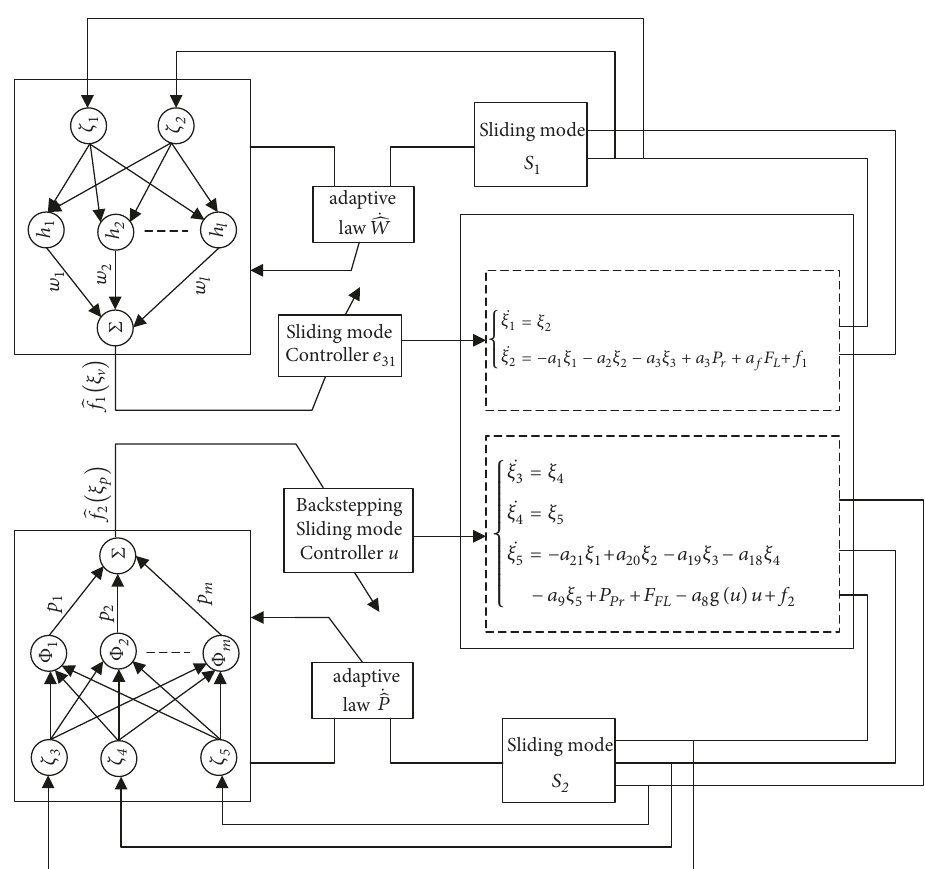
Figure 3: Dynamic pressurecylinder electrohydraulicservo pressuresystem RBF neuralnetwork backsteppingsliding mode adaptive control block